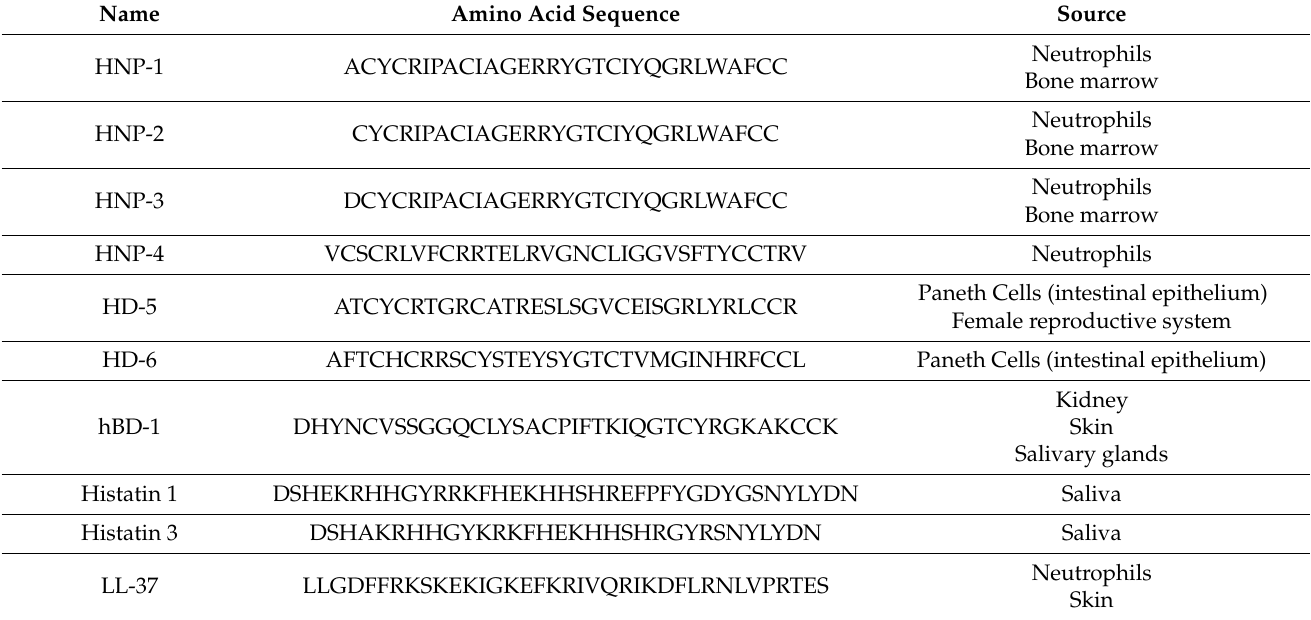
Table 5. Amino acid sequence and source of common human HDPs (adapted from ref.